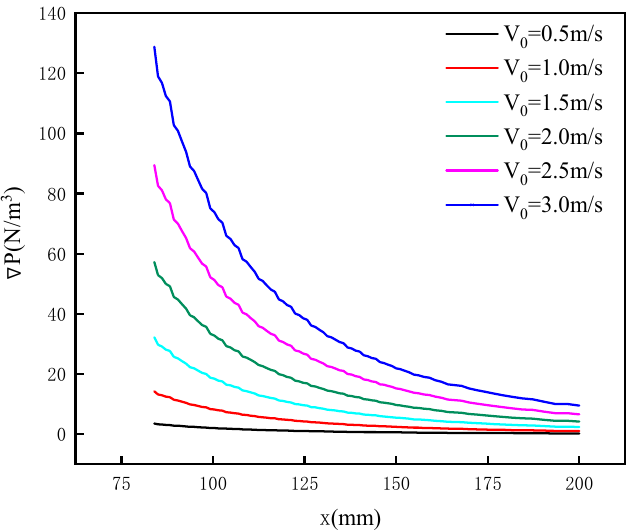
Figure 9. The pressure gradient change of the air flow along the x direction with different initial velocity. It can be seen that the airflow velocity decays the fastest near the surface of the drum (Figure 8), and the greater the initial velocity is, the greater the pressure gradient it gener- ates (Figure 9); at the same time, the pressure gradient ∇P decays rapidly as the distance x increases (Figure 9). In order to explore the influence of the drum rotation velocity on the surrounding airflow distribution, the flow field vectors when V 0 = 1.0 m/s and the drum rotation velocity is, respectively, 3, 6, 9, 12 rad/s, and the results are shown in Figure 10. It can be seen that the rotation velocity of the drum has a certain influence on the direction of the airflow. When the rotating velocity of the drum exists, the direction flow filed is not along the normal direction of the drum, but a corresponding deviation is generated in the tangential direction, that is, the direction of the sum of the drum linear velocity vector and the air velocity vector. Obviously, the greater the rotation velocity of the drum, the greater the deflection amplitude of the airflow direction, which is not conducive to the separation of non-magnetic particles toward the radial direction of the drum.